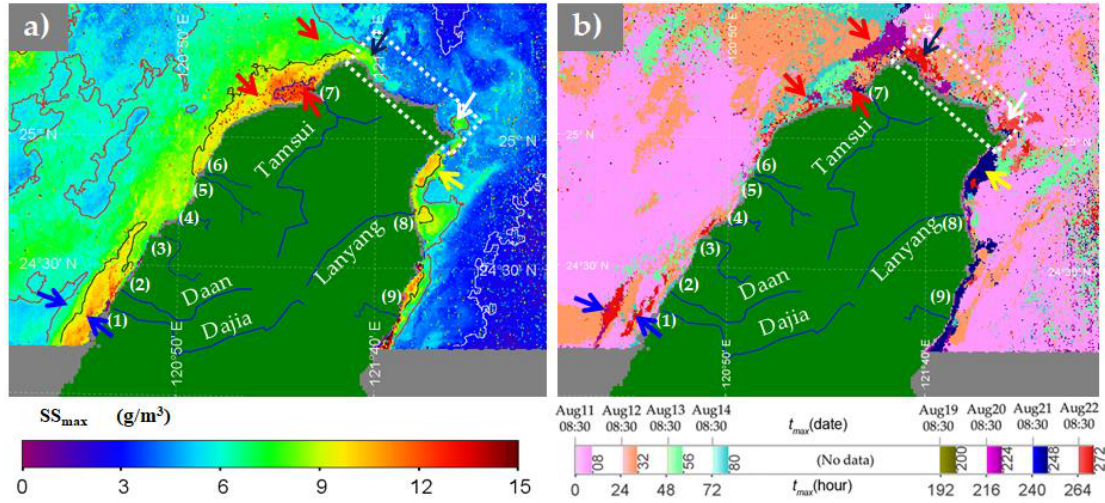
Figure 6. ( a ) Maximum suspended sediment ( SS max ); ( b ) its corresponding time ( t max ). Generally, the west coastal water from the Dajia River mouth to the Tamsui River mouth showed SS max in the range of 9–15 g/m 3 with a corresponding t max of 0–80 h (Figure 6b). This indicates that most of the west coastal water reached SS max during the post-typhoon period of 11–14 August (within four days after Typhoon Soudelor). The exceptions were two strips with t max greater than 264 h located 5 and 15 km away from the Dajia River mouth (denoted by blue arrows in Figure 6b), and three regions with t max greater than 216 h located near the Tamsui River mouth (denoted by red arrows in Figure 6b). Further small regions with 𝑡 𝑚𝑎𝑥 greater than 264 h sporadically occurred in the